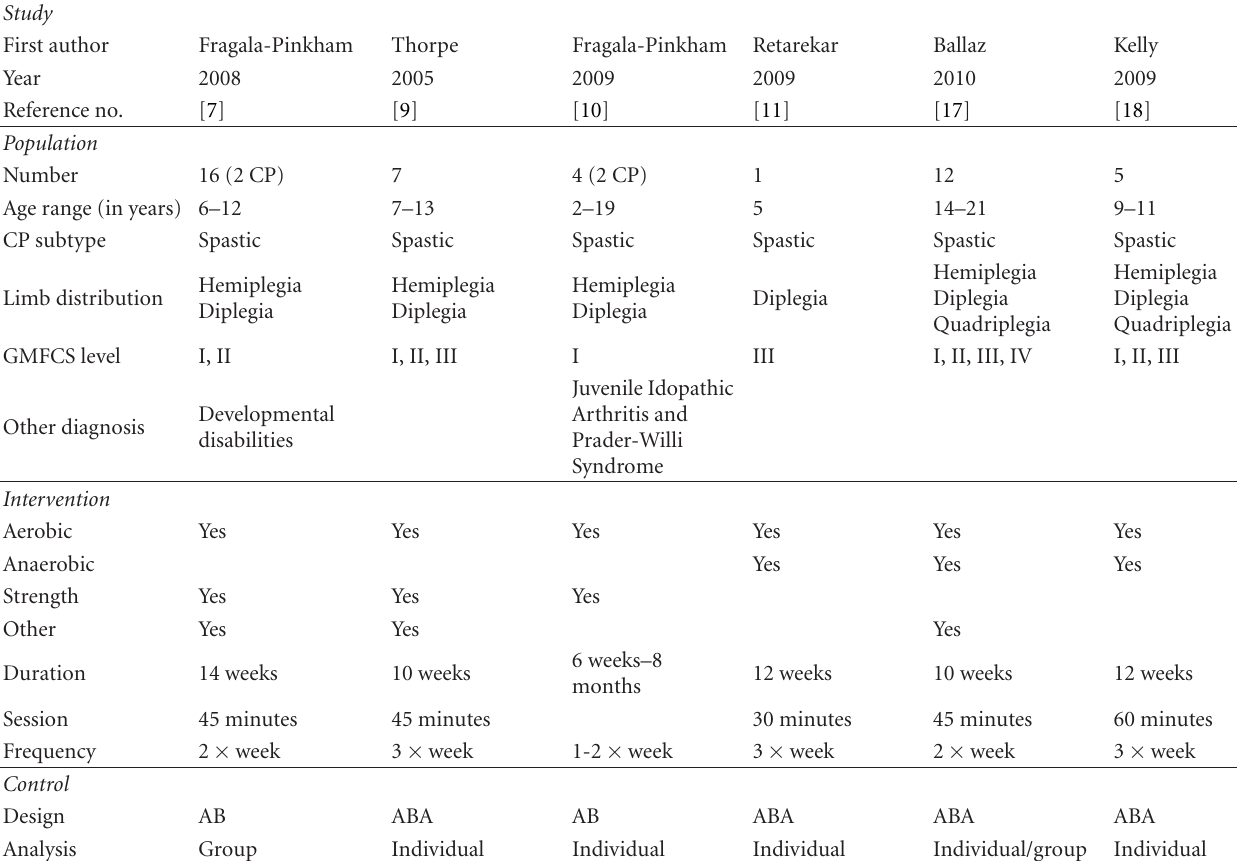
Table 2: Summary of findings of the selected intervention studies (population, intervention, and